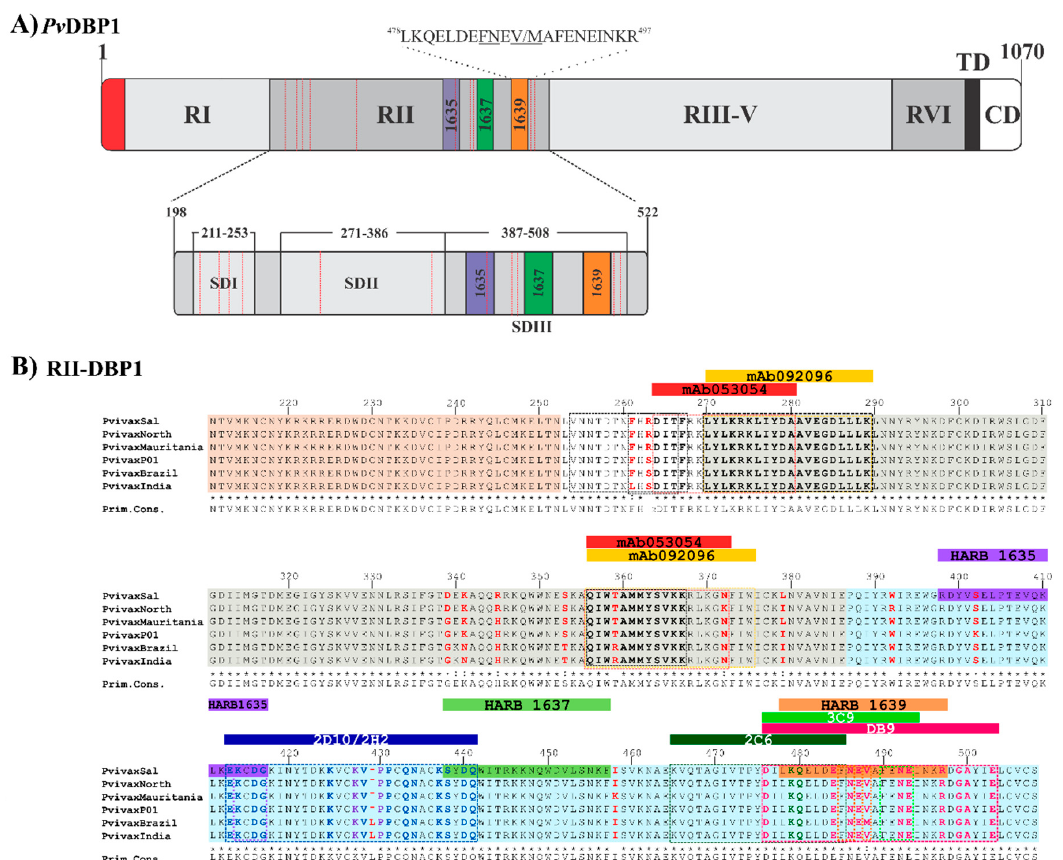
Figure 2. DBP1 representation. ( A ) Schematic representation of DBP1 primary structure showing each region’s length and representing the three HARBPs located in SD3. HARBP 1639 aa sequence is shown. The highlighted residues are critical binding residues. The red dotted lines indicate the location of the Cys involved in disulfide bridges. RI (region I), RII (region 2), RIII-V (region 3 to region 5), RVI (region 6), TM (transmembrane domain), CD (cytoplasmic domain) [42,43]. ( B ) Alignment of RII-DBP1 from the main P. vivax strains having di ff erent geographical locations. RII-DBP1 subdomains: S1 211 N-L 253 (pink), S2 271 Y-E 386 (gray), 387 S3-P-S 508 (cyan). DBP1 residues involved in binding to DARC: RII-DBP1 261 F – T 266 , 270 L – K 289 , and 356 Q – K 367 (The primary DARC binding interface) and 254 V-F 267 (secondary DARC binding interface) (black box) highlighting the critical contact residues [29,44]. Amino acid composition variations are highlighted in red. mAb 053054: 264 D-A 281 , 356 Q-N 372 (red box) and 092,096 epitopes: 249 E, 270 L-K 289 and 356 Q-W 375 (yellow box) overlapping in SD2 [28]. mAb 2D10 and 2H2 epitopes (blue box), highlighting critical contact residues (2D10-blue and 2H2-dark purple) [50]. mAb 2C6 epitope: 265 K – F 486 (dark green box), highlighting critical contact residues. mAb DB9 epitope: 476 D – E 503 (magenta box), highlighting critical contact residues [33]. mAb 3C9 epitope: 476 D – E 493 (green box), highlighting critical contact residues [55] HARBPs 1635: 398 R – G 417 (purple), 1637: 438 S – F 457 (light green) and 1639: 478 L –R 497 (apricot) located in neutralizing epitopes’ SD3 region [56]. HARB 1639 critical binding residues matching mAb 3C9 are highlighted (arrows). HARBPs: high activity reticulocyte binding peptides. mAbs: monoclonal antibodies. Cys: